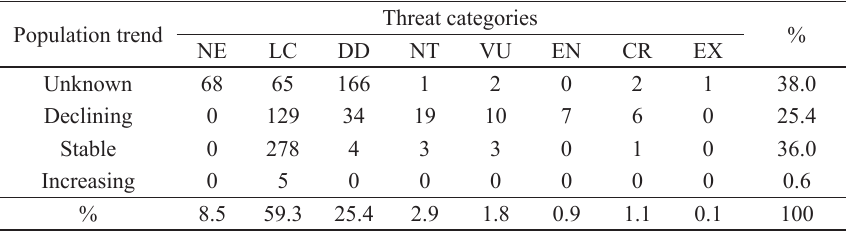
Relative number of species listed by threat category and population trend (N = 804), according to the IUCN Red List categories (i.e., NE: Not Evaluated, LC: Least Concern, DD: Data Deficient, NT: Near